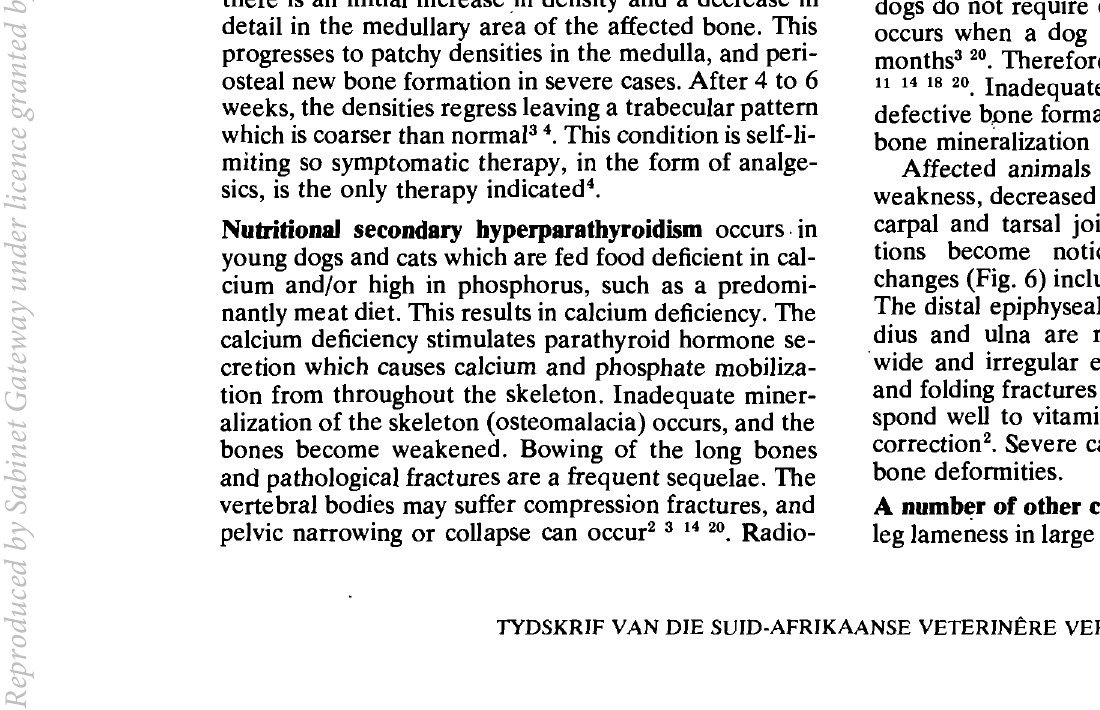
Fig. 4. Diagram of the lateral radiograph of the carpal findings in the middle phase of panosteitis. Diaphysis of the ulna has a patchy increase in density of the medullary cavity (A). There is also periosteal (8) and endosteal (C) new bone formation which results in accentuation of these lines. Normal meta physes (0), normal growth plates (E), and normal epiphyses